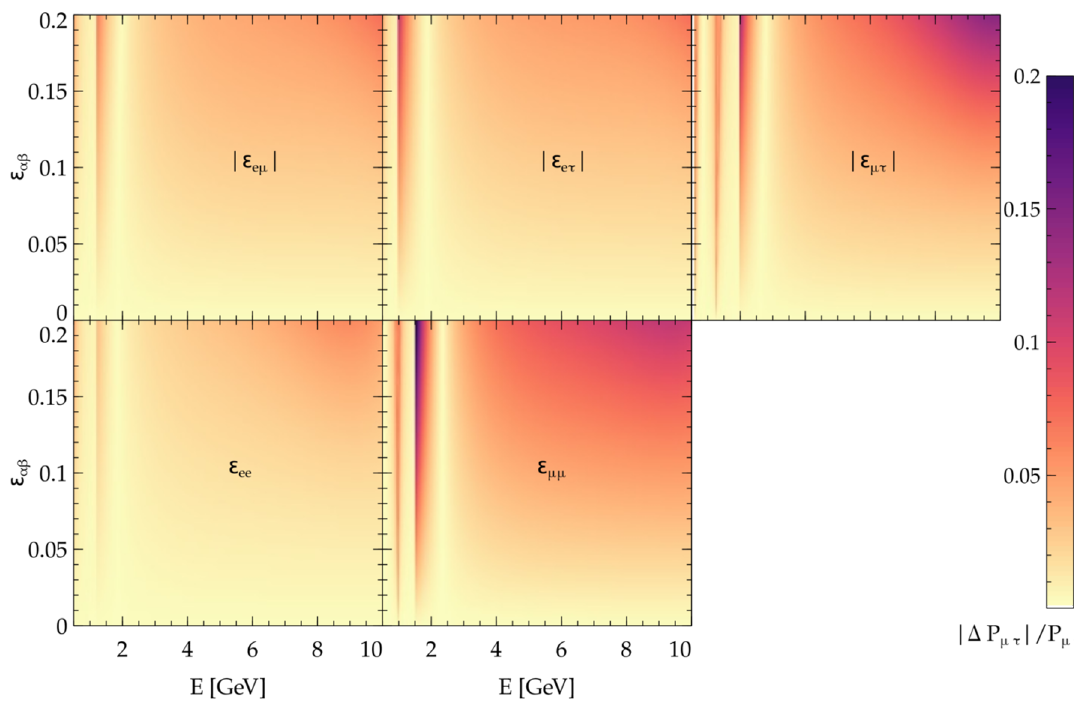
Figure 4 . Heatmap for | ∆ P µτ | /P µτ as a function of the NSI parameters ε eµ , ε eτ , ε µτ , ε ee , ε µτ (taken one-at-a-time and assuming them to be real) and the neutrino energy, E .